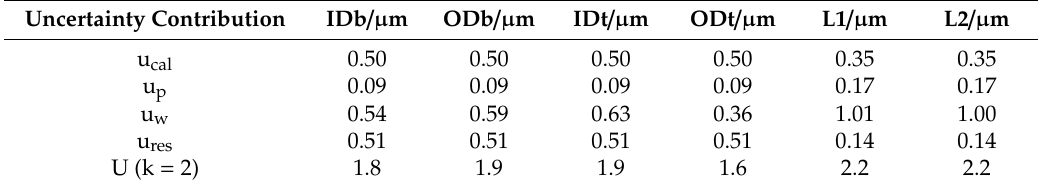
Table 2. Average uncertainty contributions and expanded uncertainty U for the IM parts.